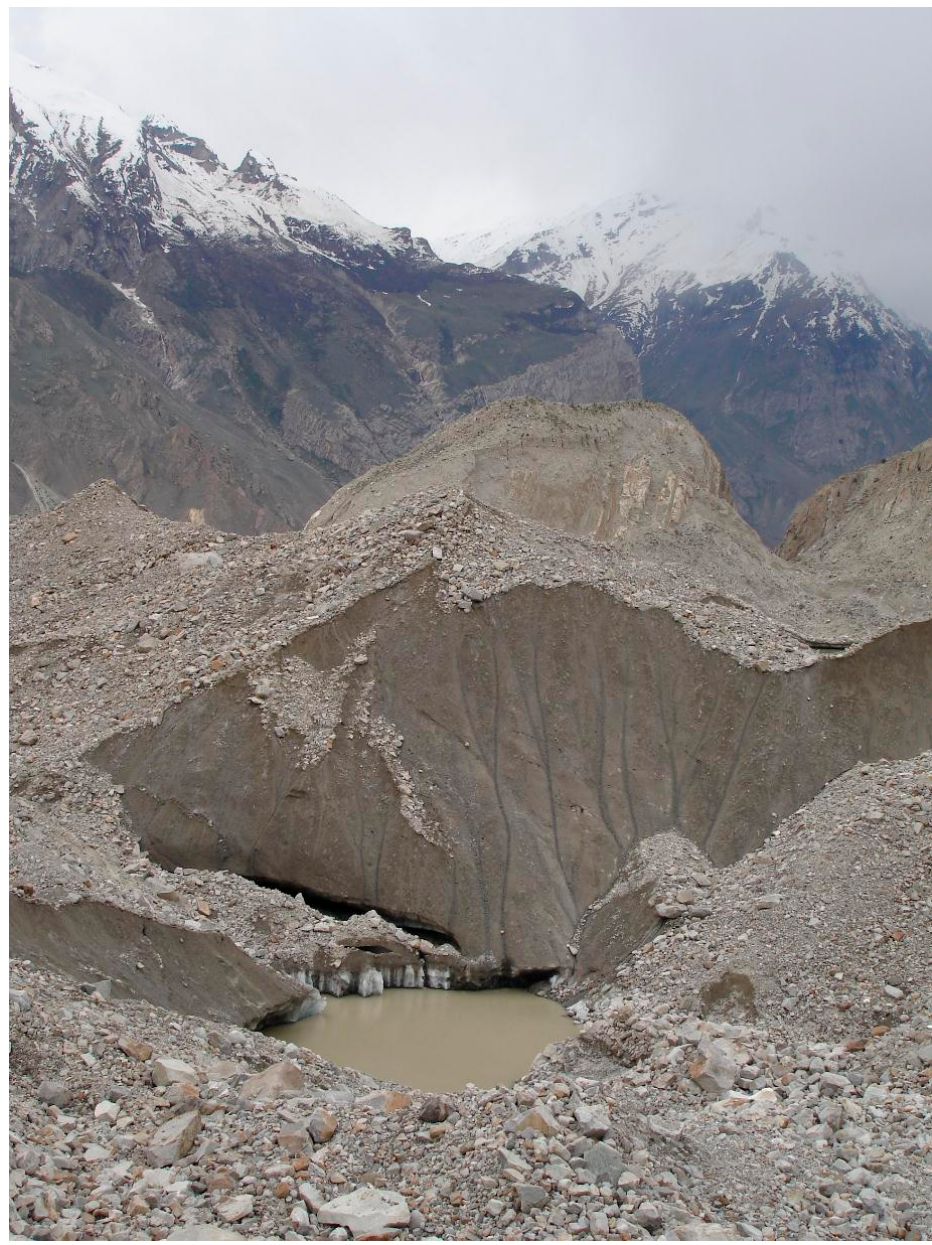
Figure 5. A debris-covered ice cliff and a small supraglacial lake on Baltoro glacier (photo credit: Andrew G.B. Bush, 2005).